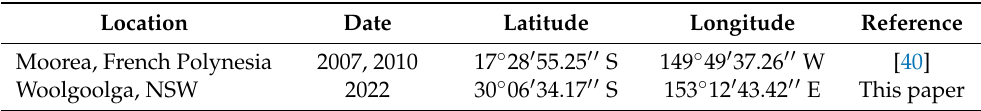
Table 2. South Pacific distribution records of Hypselodoris bertschi